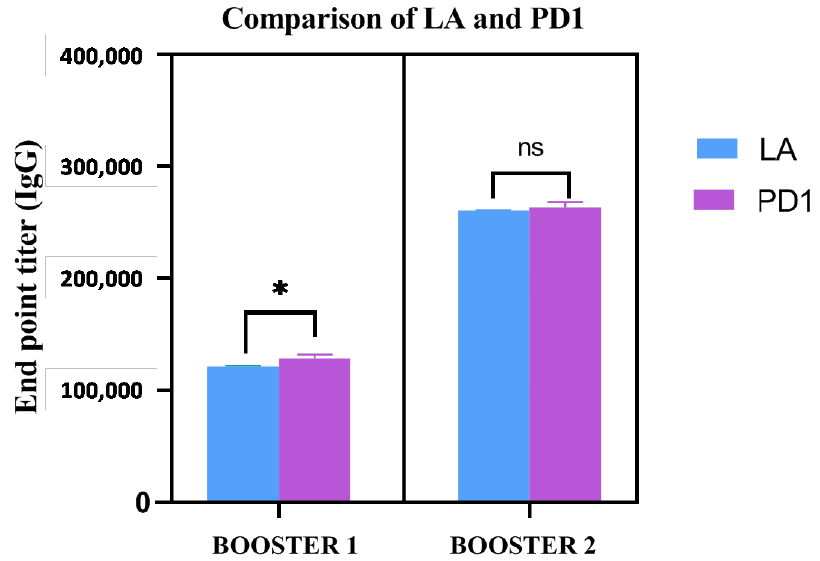
Figure 9. Endpoint titers of IgG antibody estimated by ELISA from serum collected after first and second boosters from vaccinated animal groups, i.e., LA (alum adjuvanted LcrV) and PD1 (formulation stored at 30 ◦ C for three weeks). n =5 for each group. * p -value = 0.047, ns represents no significance.